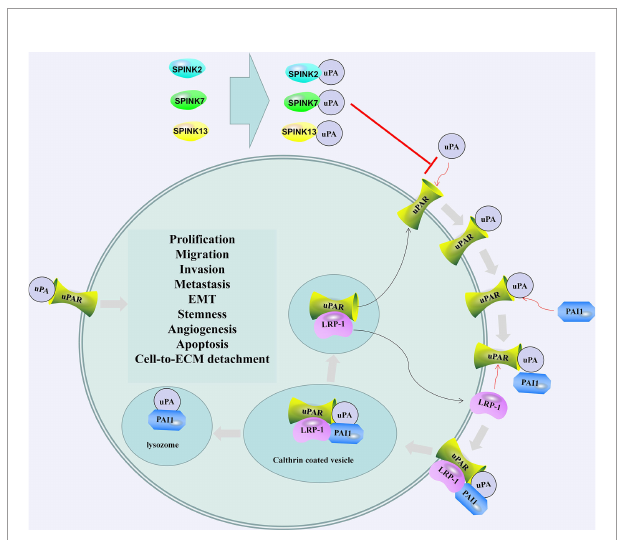
FIGURE 2 | SPINK2/7/13 and plasminogen activator inhibitor 1 (PAI1) regulates the activation and regulation of uPA/uPAR. SPINK2/7/13 interacts with uPA and hinders the formation of uPA/uPAR complex. The combination of PAI1 and uPA/uPAR led to the internalization of the entire assembly. uPA and PAI-1 are degraded in the lysosome, and Low-density lipoprotein (LDL)- related protein-1 (LRP-1) and uPAR are recycled into the membrane. The recovered uPAR can be combined with the available uPA (106). After activation, uPA can cause the degradation of the extracellular matrix and promote cell proli fi cation, migration, invasion, metastasis, EMT, stemness, and